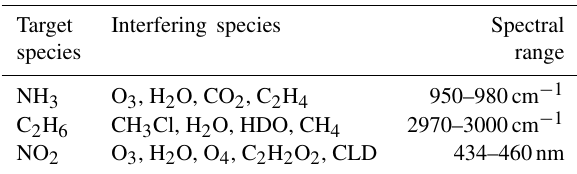
Table 2. Spectral fit windows used in the